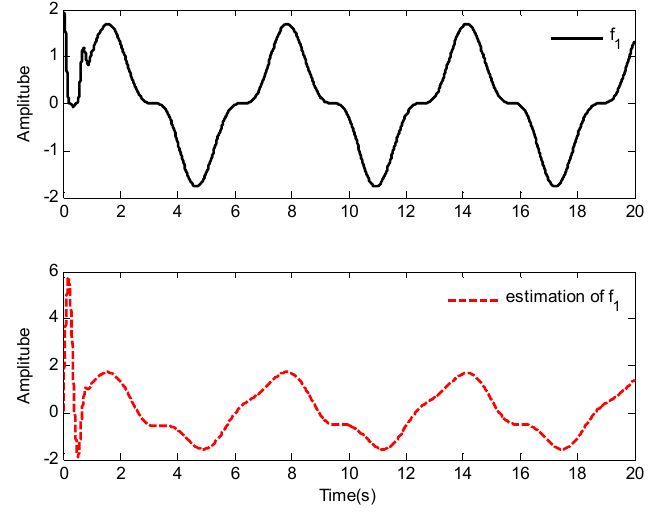
ˆ f ˆ f ˆ f . Figure 4. Response of f 1 and . 1 . 1 1